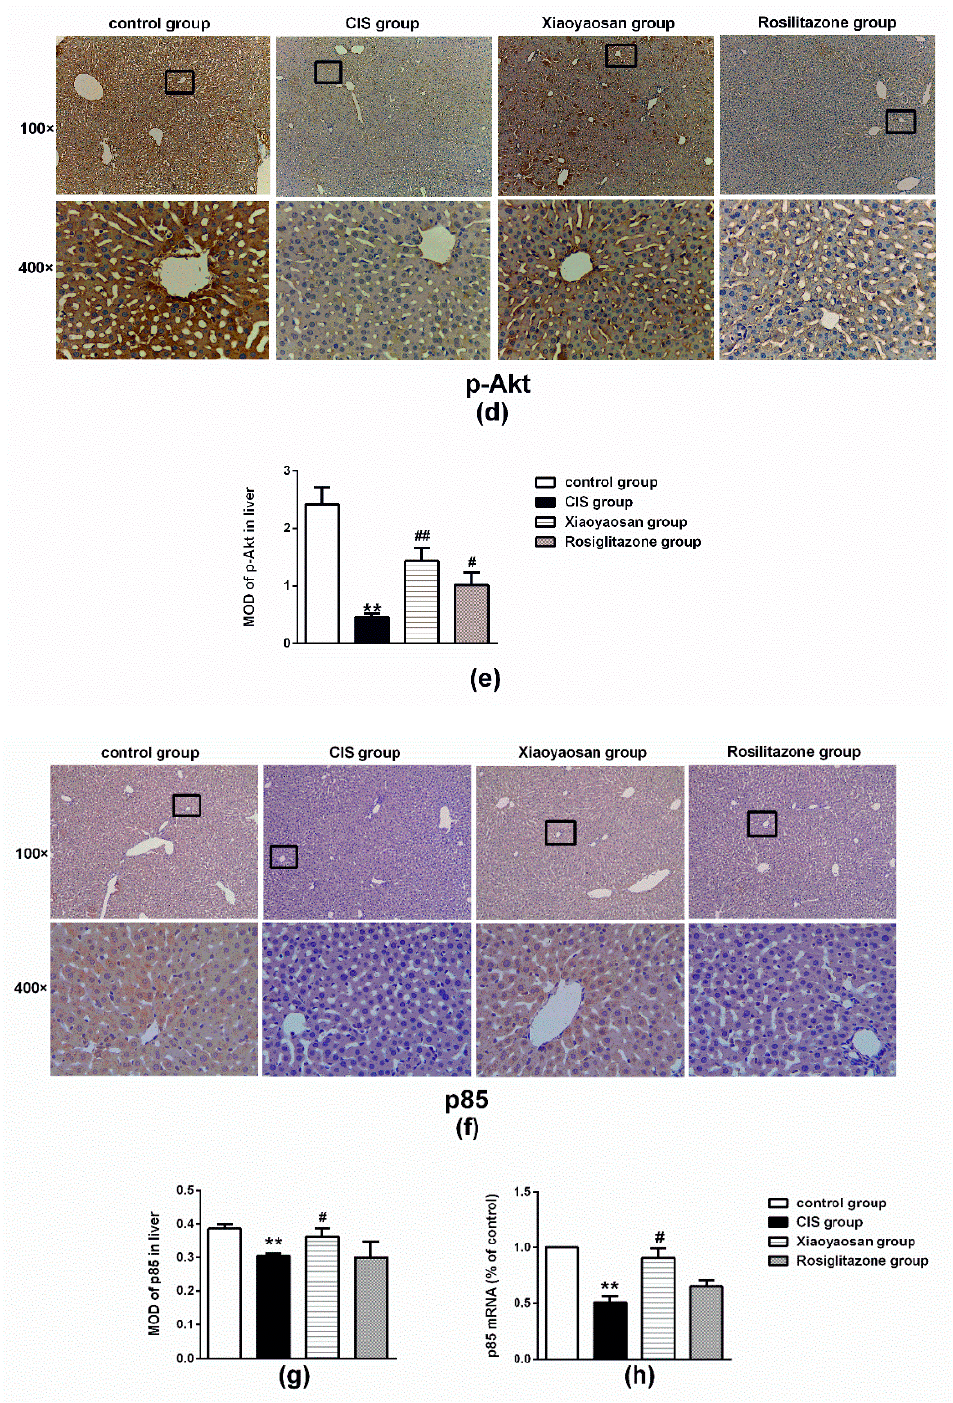
Figure 6. Effects of Xiaoyaosan on the expression of Akt, p-Akt and p85 proteins and mRNAs in a stress-induced rat liver. ( a ) Representative micrographs of immunohistochemical staining for Akt proteins (100 × and 400 × magnification) in the liver. ( b ) Quantitative analysis of Akt protein levels. ( c ) Expression of Akt mRNA in the rat liver. ( d ) Representative micrographs of immunohistochemical staining for p-Akt protein (100 × and 400 × magnification) in the liver. ( e ) Quantitative analysis of p-Akt protein levels. ( f ) Representative micrographs of immunohistochemical staining for p85 protein (100 × , 400 × magnification) in the liver. ( g ) Quantitative analysis of p85 protein levels. ( h ) Expression of p85 mRNA in the rat liver. MOD, mean optical density. Data are presented as the means ± SEM from 5 rats per group for determination. ** p < 0.001 versus the control group. # p < 0.05 or ## p < 0.001 versus the CIS group.